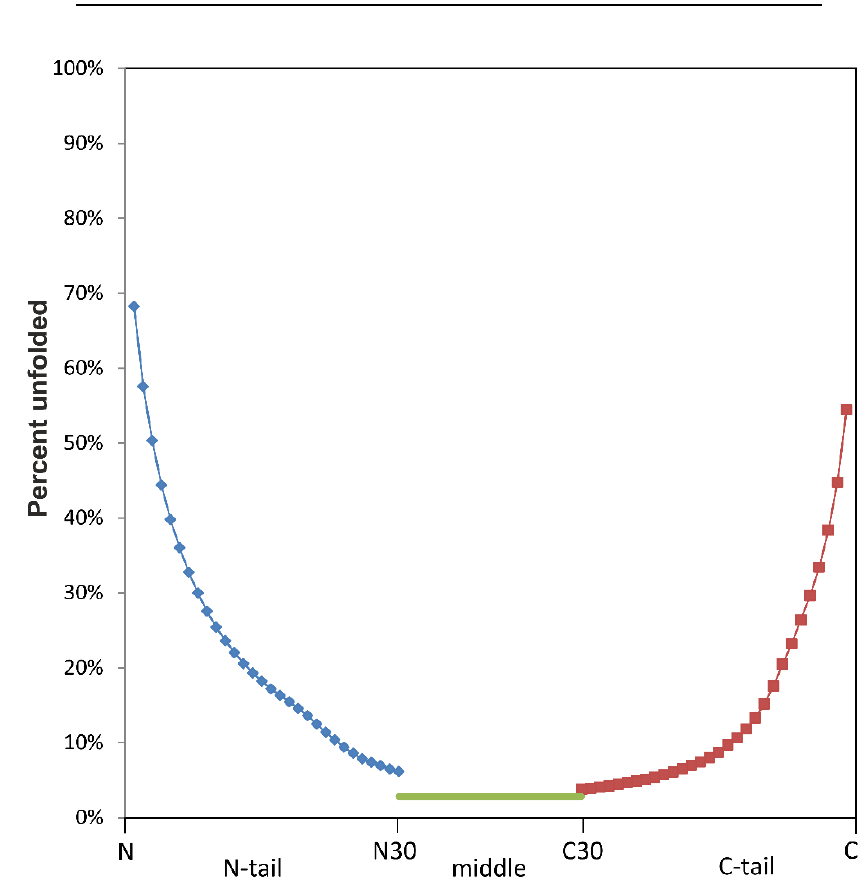
Figure 4. Statistics of all disordered residues from the clustered PDB at the 75% level of identity for the different positions of protein chains. Table 3. Comparison of data for the different versions of libraries of disordered patterns (L min is the minimum length of pattern and L max is the maximum length of pattern).